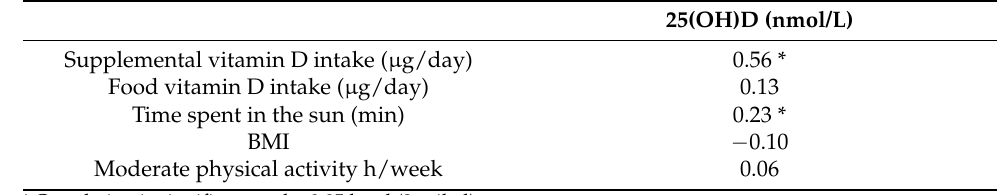
Table 3. Pearson’s correlation coefficients (r) of predictors of vitamin D status in healthy women from the Central Slovenian region aged between 44 and 65 years, who were included in the study carried out between 1 March 2021 and 31 May 2021 ( n =